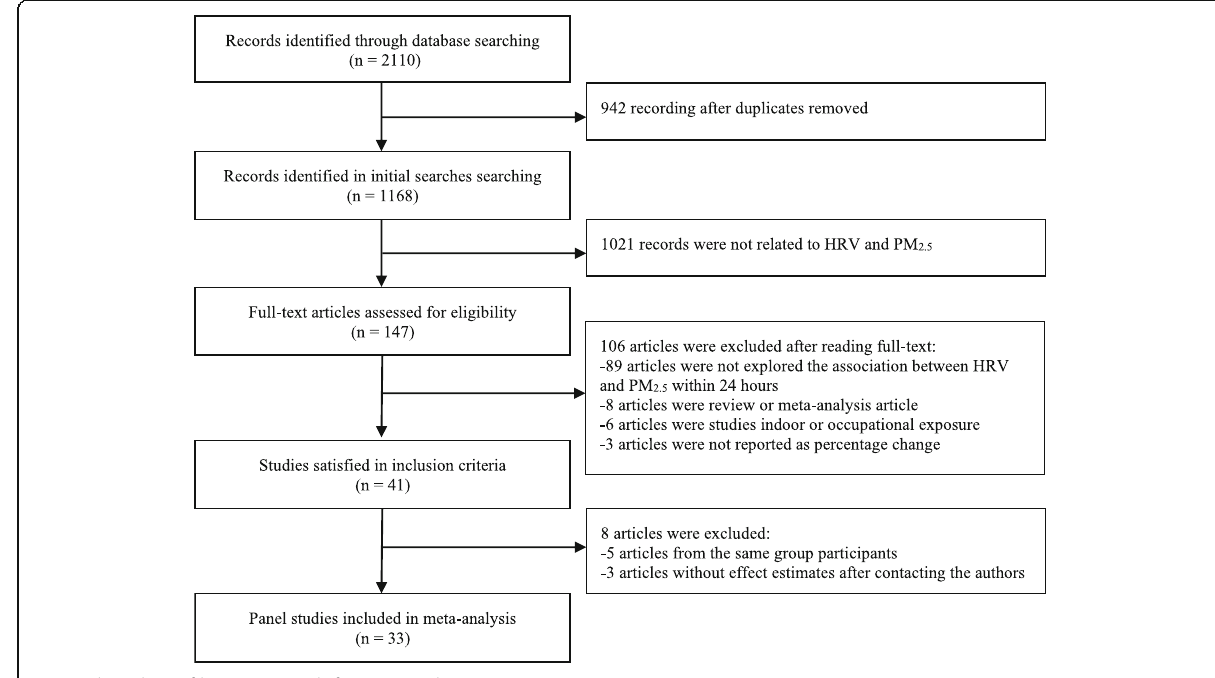
Fig. 1 Flow-chart of literature search for